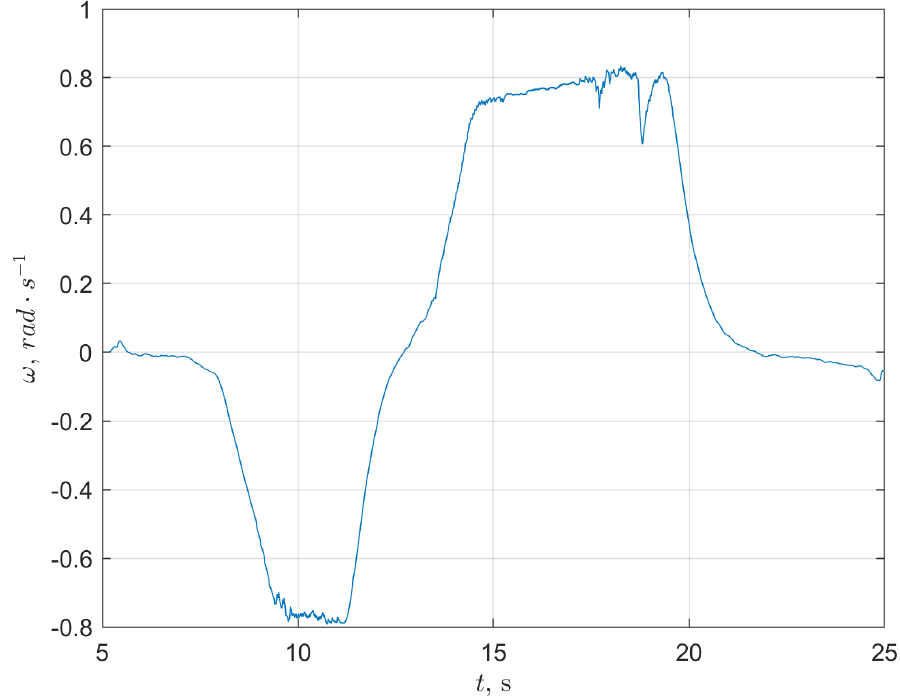
Figure 24. Changes in angular rate over time for the lowest value of the cost function equal to 0.8369—track 2.